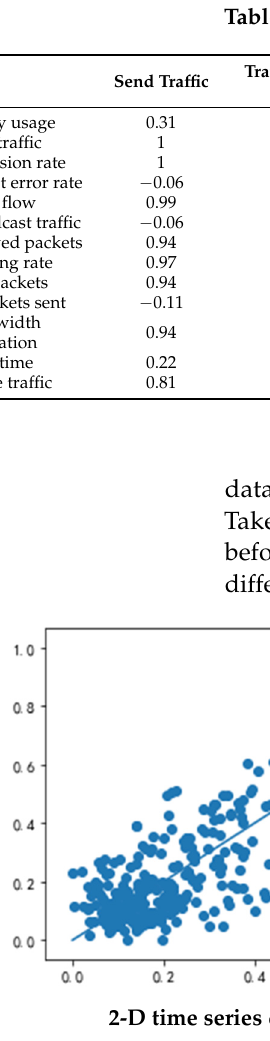
Figure 4. Data conversion diagram.